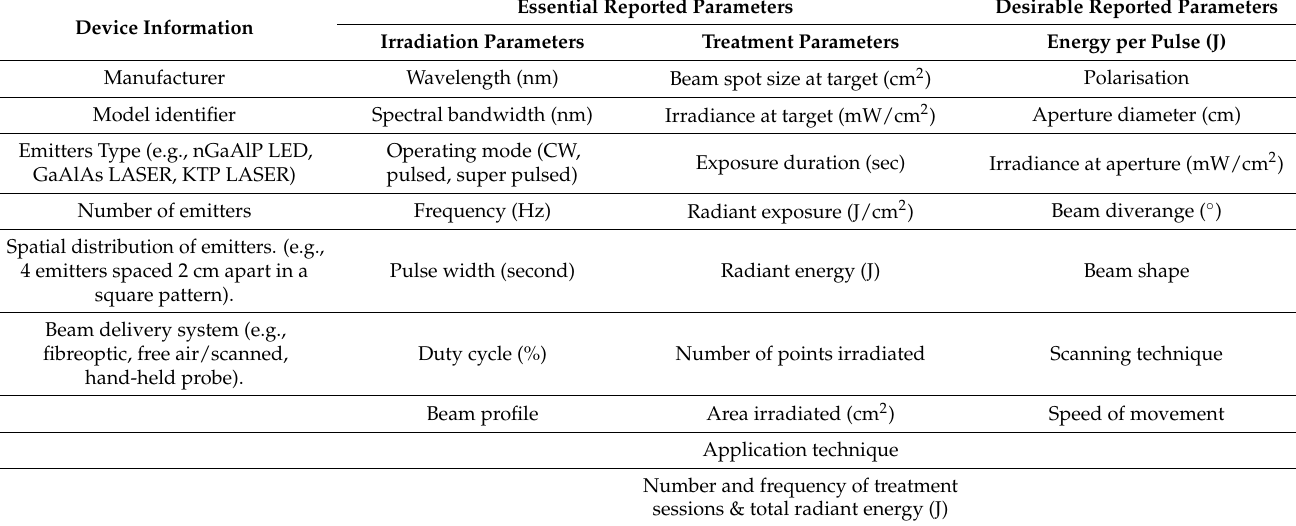
Table 6. Represents the essential and desirable laser treatments that should be reported to standardise PBM protocol and improve methodology reproducibility among clinicians and facilitate the comparison of results among researchers. Adapted with permission from ref. [120], Copyright 2011 Mary Ann Liebert. List of the abbreviations are listed in Supplementary File